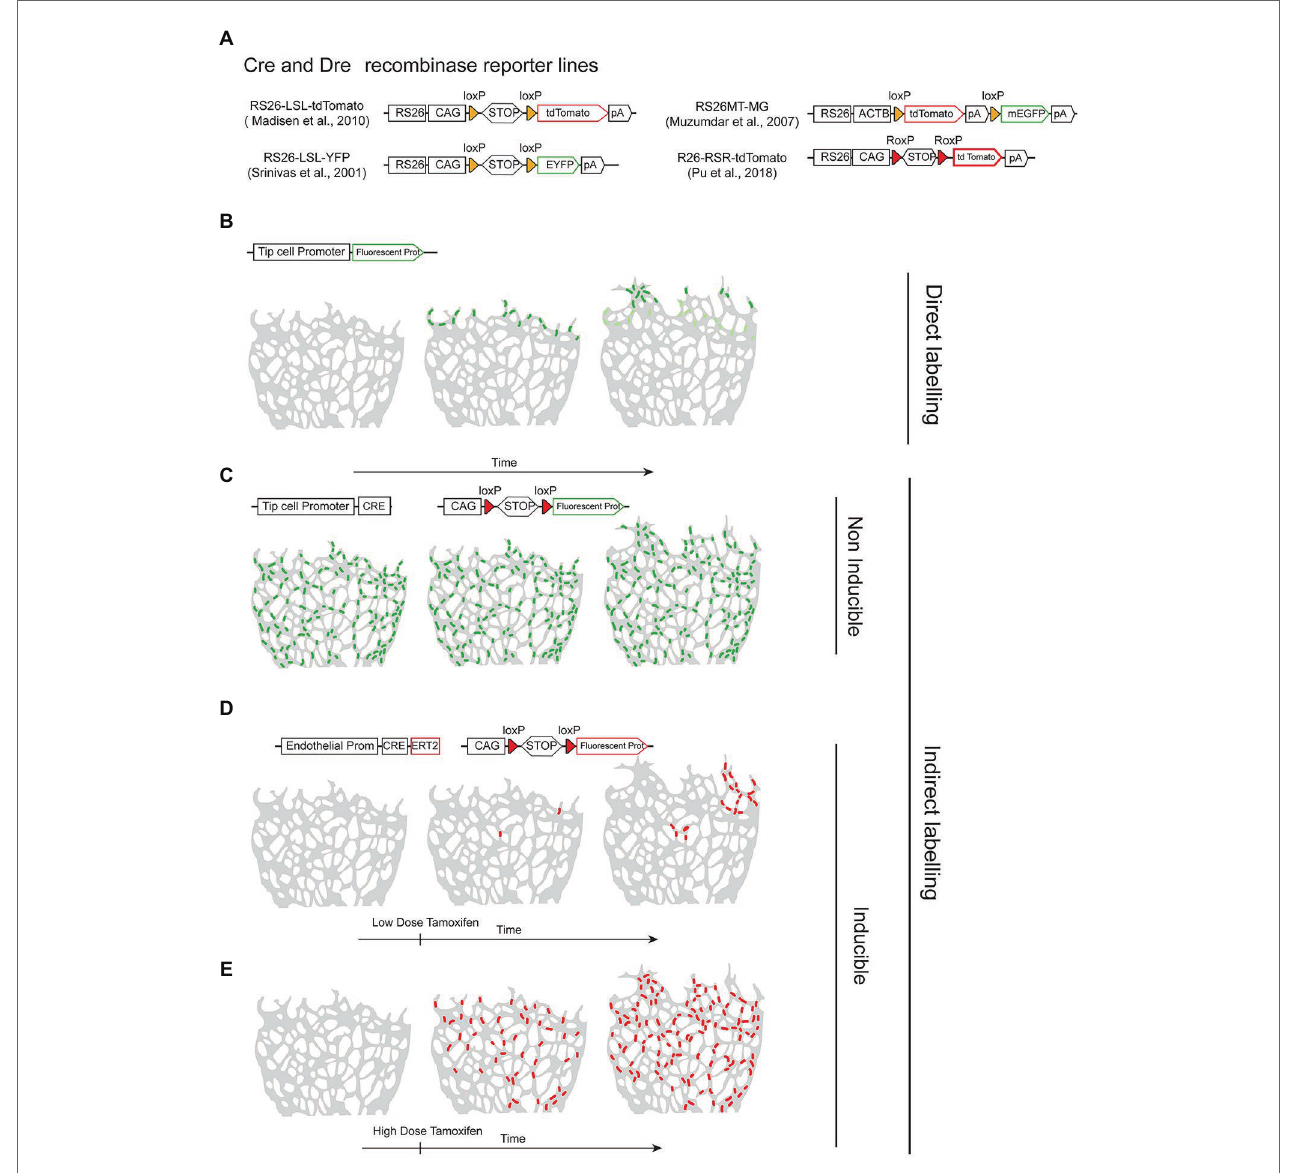
FIGURE 2 | Recombinase reporter lines and their outcomes. (A) Schematic overview of distinct recombinase-inducible and Rosa26-locus targeted fluorescent reporters. (B) Example of direct labelling achieved by using an allele containing a vascular tip-cell-specific promoter driving expression of a fluorescent protein in the retina angiogenesis model. Only tip cells express the promoter and the reporter protein. (C) Example of a non-inducible and indirect labelling strategy using a tip-cell-specific Cre line in combination with a fluorescent reporter line. Cre is expressed in tip-cells and all their progeny during tissue development and therefore the fluorescent reporter is expressed in many endothelial cells, not only tip cells. (D,E) Example of indirect labelling using an inducible CreERT2 line expressed in all endothelial cells, in combination with a reporter line. Cre is only activated after tamoxifen administration and recombination/cell labelling occurs at a controlled time- point. Number of recombination events and cellular labelling can be modulated by the dose of